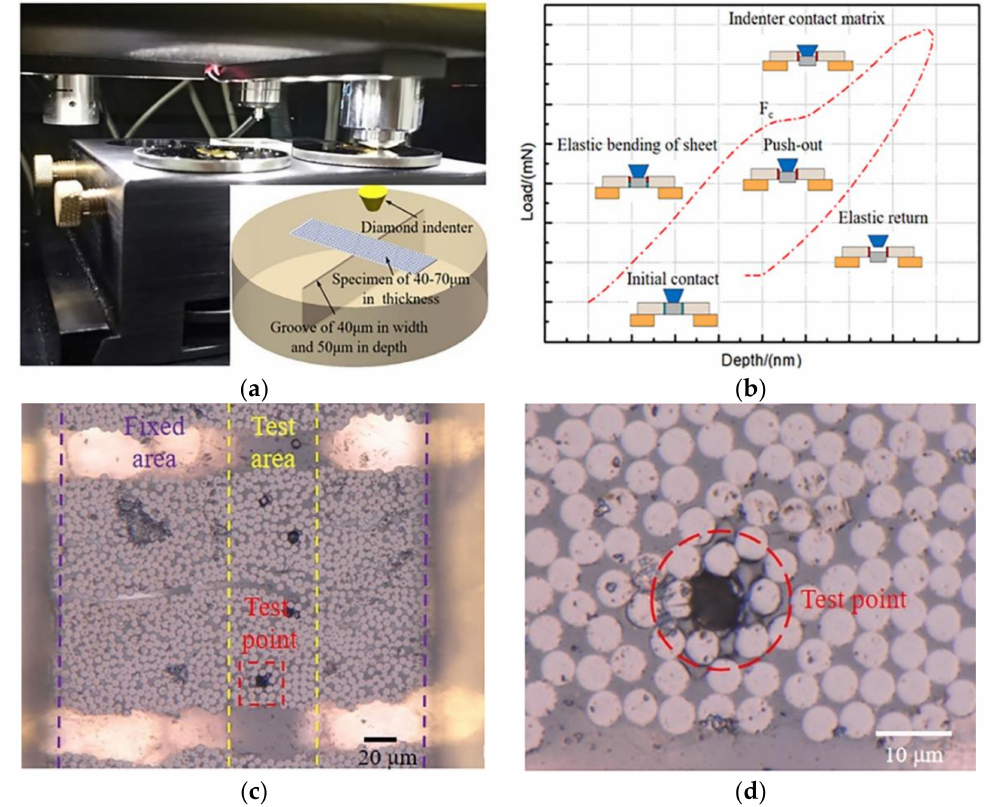
Figure 3. The single fiber push-out test, ( a ) experimental set-up used for the push-out test, ( b ) rep- resentative load-displacement curve of the push-out test, ( c ) 1000 times microscopy imaging of the frontside surface, ( d ) 2000 times microscopy imaging showing the detail of the target fiber after the